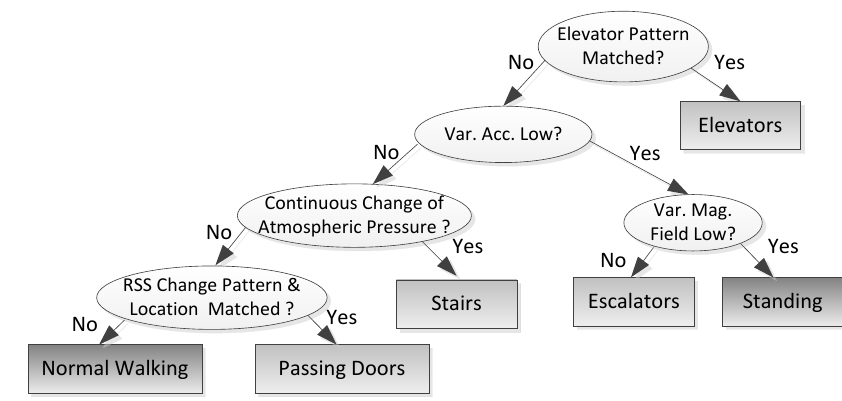
Figure 2. Identification of landmarks using a decision tree.